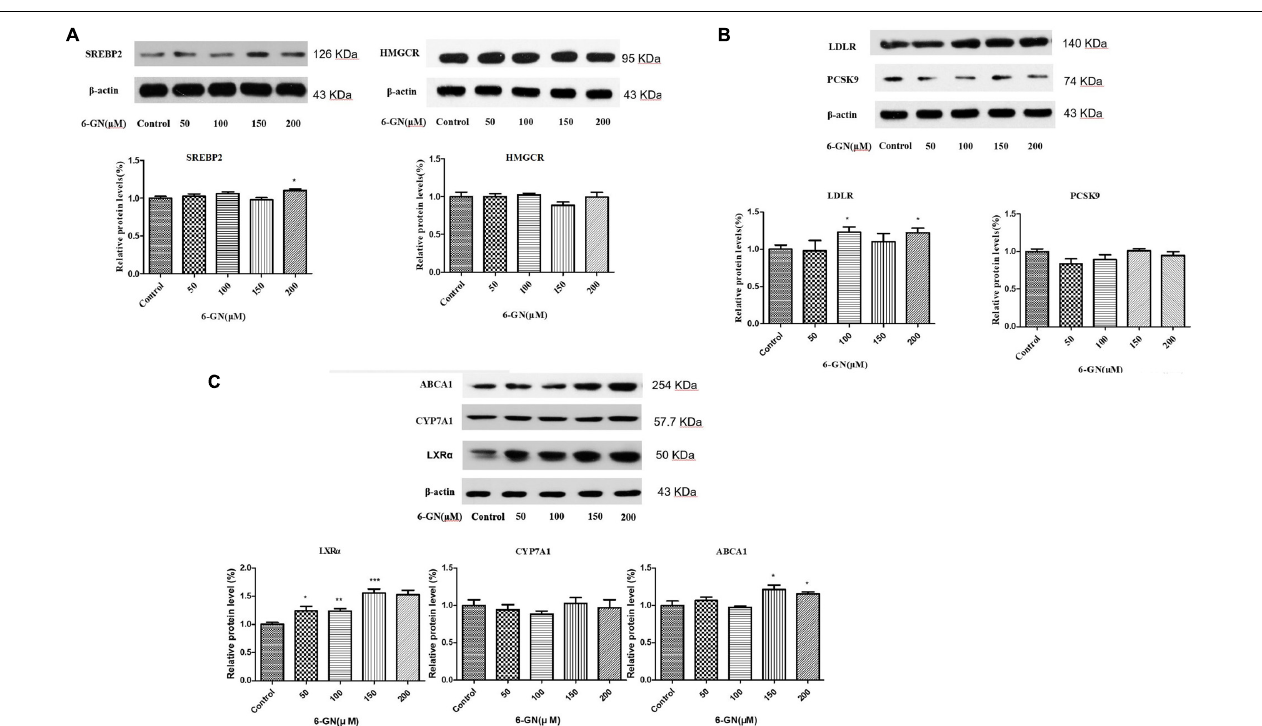
FIGURE 5 | Effect of 6-GN on the related protein expressions of (A) SREBP2, HMGCR, (B) LDLR, PCSK9, (C) ABCA1, CYP7A1, and LXR α in HepG2 cells. HepG2 cells were disposed with or without various concentrations of 6-GN (50, 100, 150, and 200 µ M) for 24 h ( n = 3). Values were represented as mean ± SD of three independent experiments. ∗ p < 0.05 versus control, ∗∗ p < 0.01 versus control, ∗∗∗ p < 0.001 versus control. LDLR and PCSK9 were run together with β -actin in the same SDS–PAGE and transferred to the membrane; ABCA1, CYP7A1, and LXR α were run together with β -actin in the same SDS–PAGE and transferred to the membrane; SREBP2 and β -actin were run together in the same SDS–PAGE and transferred to the membrane; HMGCR and β -actin were run together in the same SDS–PAGE and transferred to the membrane. Then, the different protein bands in the same membrane were cut separately before binding the different primary